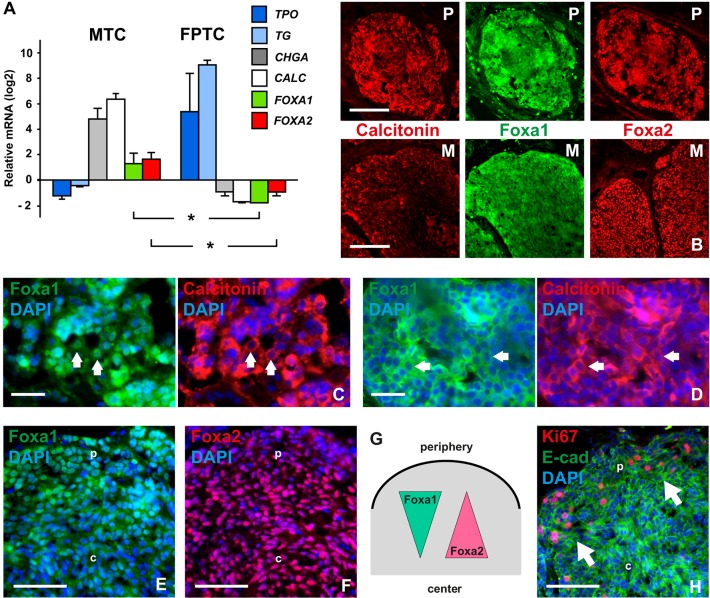
Expression of Foxa1 and Foxa2 in neuroendocrine thyroid cancer. (A) Comparison of microarray data sets from human medullary thyroid carcinoma (MTC; n=9) and follicular variant of papillary thyroid cancer (FPTC; n=7). FOXA1/FOXA2 expression levels relative to mRNAs of biomarkers for the respective tumor type (CALC, calcitonin; CHGA, chromogranin A; TG, thyroglobulin; TPO, thyroid peroxidase) are shown as the difference from the mean of all genes in each data set. Asterisks indicate P<0.001. Error bars represent s.d. (B-F) Immunofluorescence staining of Foxa1 and Foxa2 in tumor tissues from an MTC patient. Sections were co-stained for calcitonin to distinguish tumor from stromal cells. (B) Nodules from primary tumor (P) and lymph node metastasis (M) at low magnification. (C,D) Detailed views of tumor tissues with different cell densities. Arrows indicate accumulation of Foxa1 predominantly in nuclei (in C) or cytoplasm (in D) associated with low and high cellularity, respectively. (E) Nuclear accumulation of Foxa1 differs between peripheral (p) and central parts (c) of tumor nodule. (F) Expression levels of Foxa2 in peripheral (p) versus central parts (c) of tumor nodule. (G) Distinct expression pattern of Foxa1 and Foxa2 in MTC related to tumor tissue organization (depicted from data shown in E,F). Increase/decrease refers to nuclear accumulation. (H) Distribution of proliferating cells in tumor nodule. Arrows indicate clusters of Ki67+ cells in the peripheral zone (p) facing the tumor stroma. Ki67+ cells are not present in the nodule center (c). Scale bars: 100 µm (B); 25 µm (C,D); 50 µm (E,F,H).